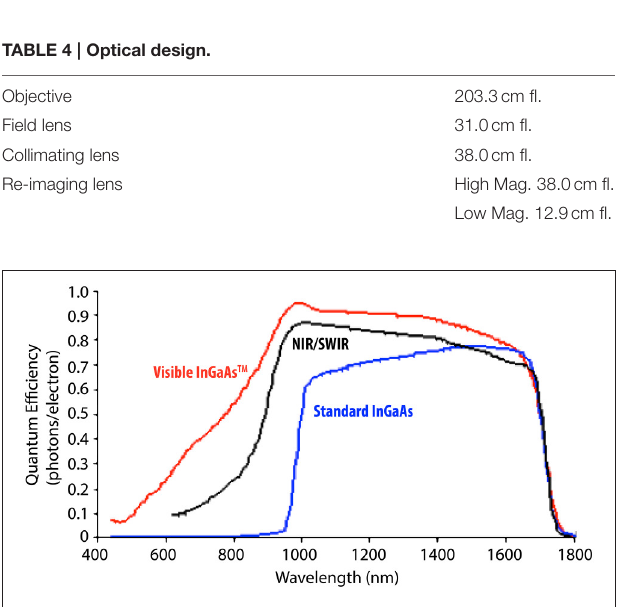
FIGURE 4 | Detector quantum efficiency (red curve) of the Goodrich Corp. InGaAs High Resolution Visible + SWIR Camera for WAMIS, compared to other camera models (NIR/SWIR and standard